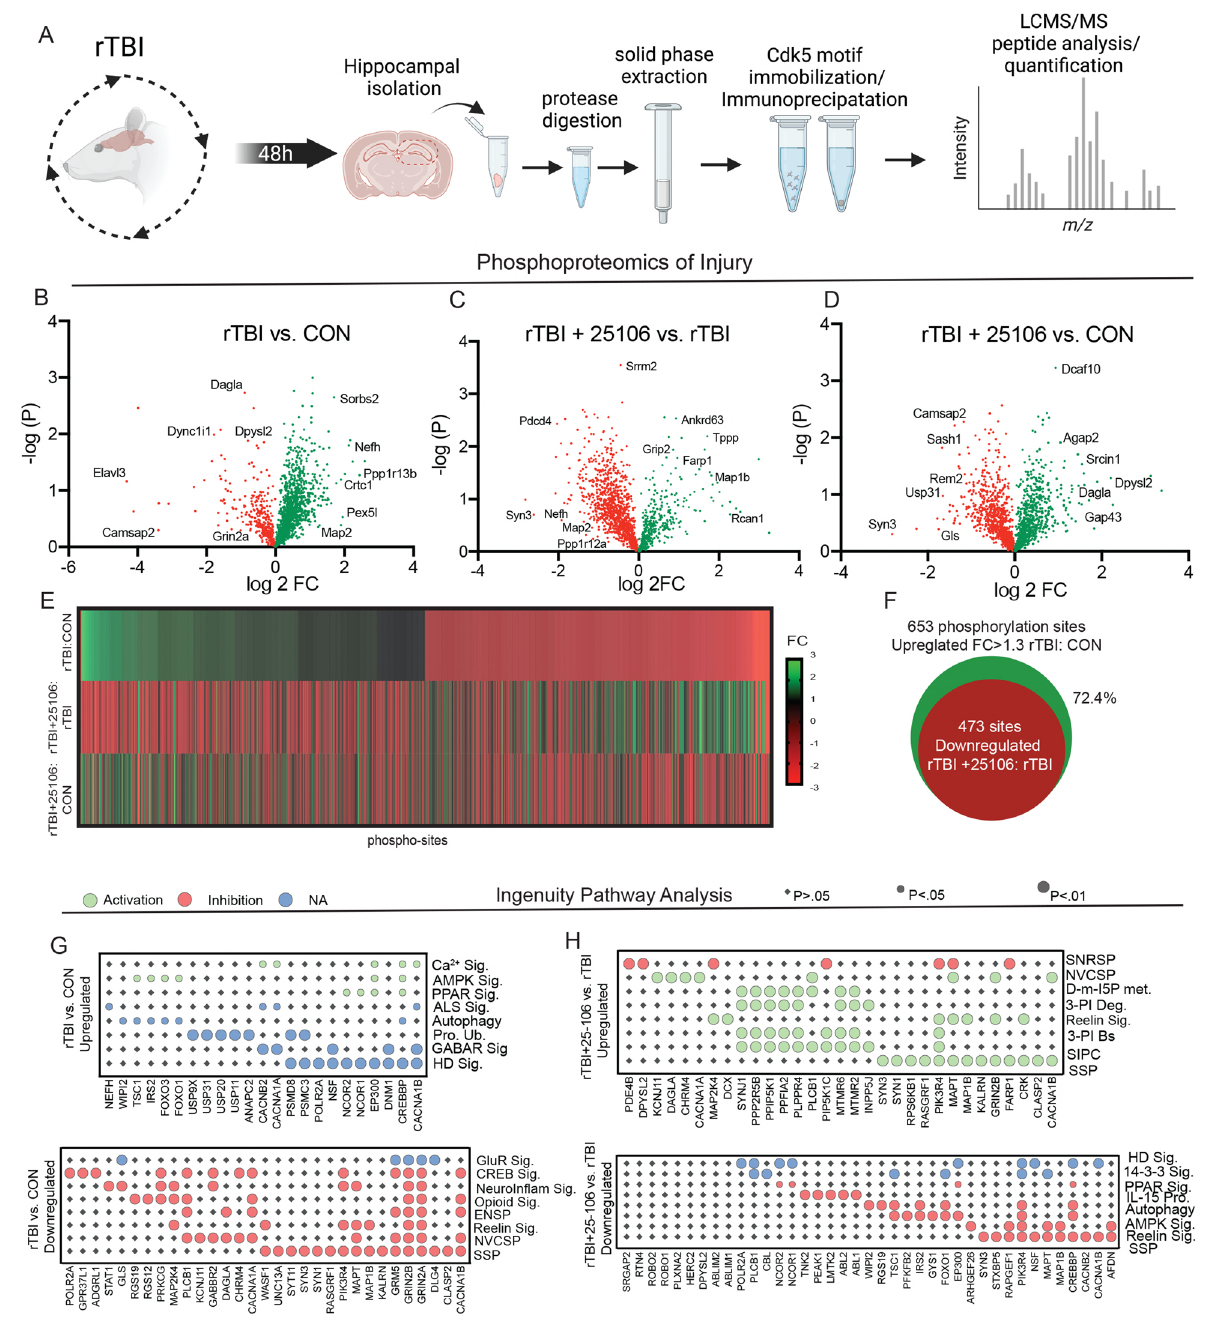
Figure 6. Cdk5 enriched phosphoproteomics of rTBI. ( A ) Experimental design schematic displaying tissue isolation, extraction, Cdk5 motif enrichment, and peptide detection and analysis. ( B ) Volcano plot of differentially phosphorylated proteins between rTBI and con rats. (n = 5 pooled brains in duplicate per group) (increased sites in green decreased sites in red). ( C ) Volcano plot of differentially phosphorylated proteins between rTBI + 25–106 and rTBI alone rats. ( D ) Volcano plot of differentially phosphorylated proteins between rTBI + 25–106 and con rats. ( E ) Heatmap of all differentially phosphorylated sites across three comparisons in B-D expressed by fold change of each phosphor-site. ( F ) Venn diagram representing overlapping sites with positive FC ≥ 1.3 in rTBI:CON and negative FC in rTBI + 25–106:rTBI. ( G ) Dot-plot display of Ingenuity Pathway Analysis of phosphoproteins and canonical pathways upregulated FC ≥ 1.3 by rTBI:Con (Top) and downregulated with a FC ≤ − 1.3 by rTBI:Con (bottom). ( H ) Dot-plot display of Ingenuity Pathway Analysis of phosphoproteins and canonical pathways upregulated FC ≥ 1.3 by rTBI + 25,106:rTBI (Top) and downregulated with a FC ≤ − 1.3 by rTBI + 25–106:rTBI